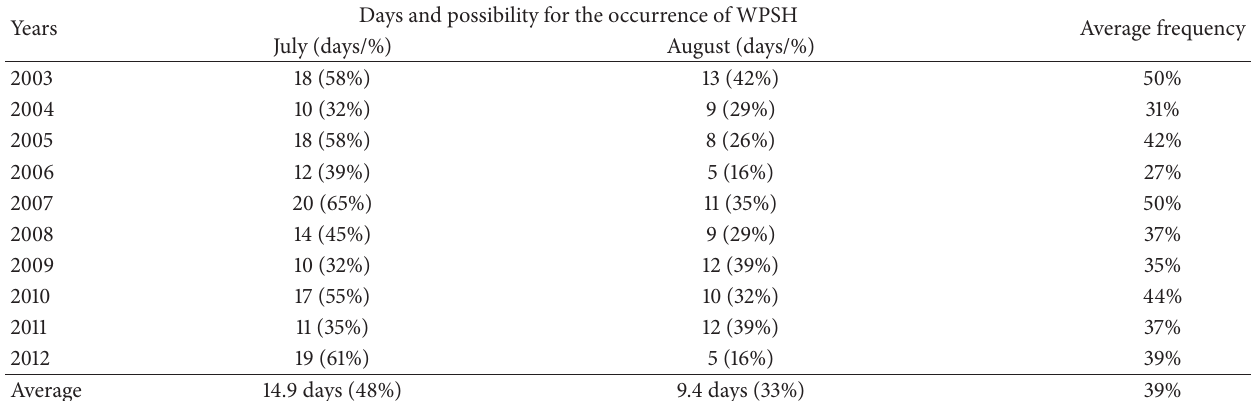
Table 1: Occurrence of WPSH in July and August in east China from year 2003 to